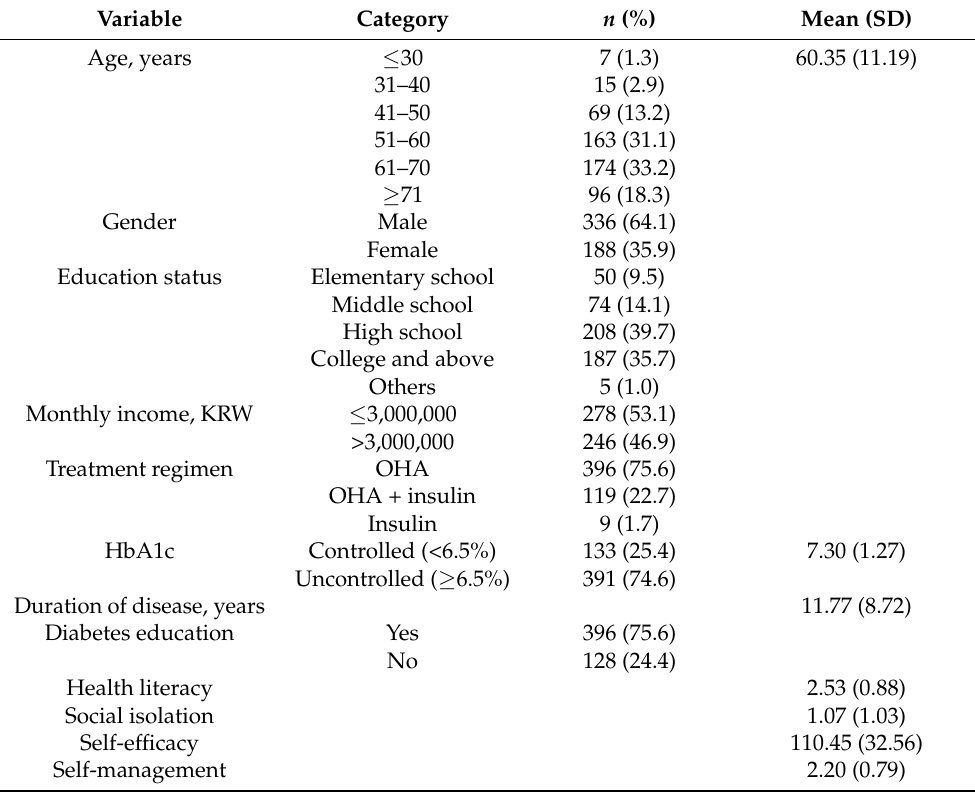
Table 1. Descriptive statistics of participants and study variables ( N =